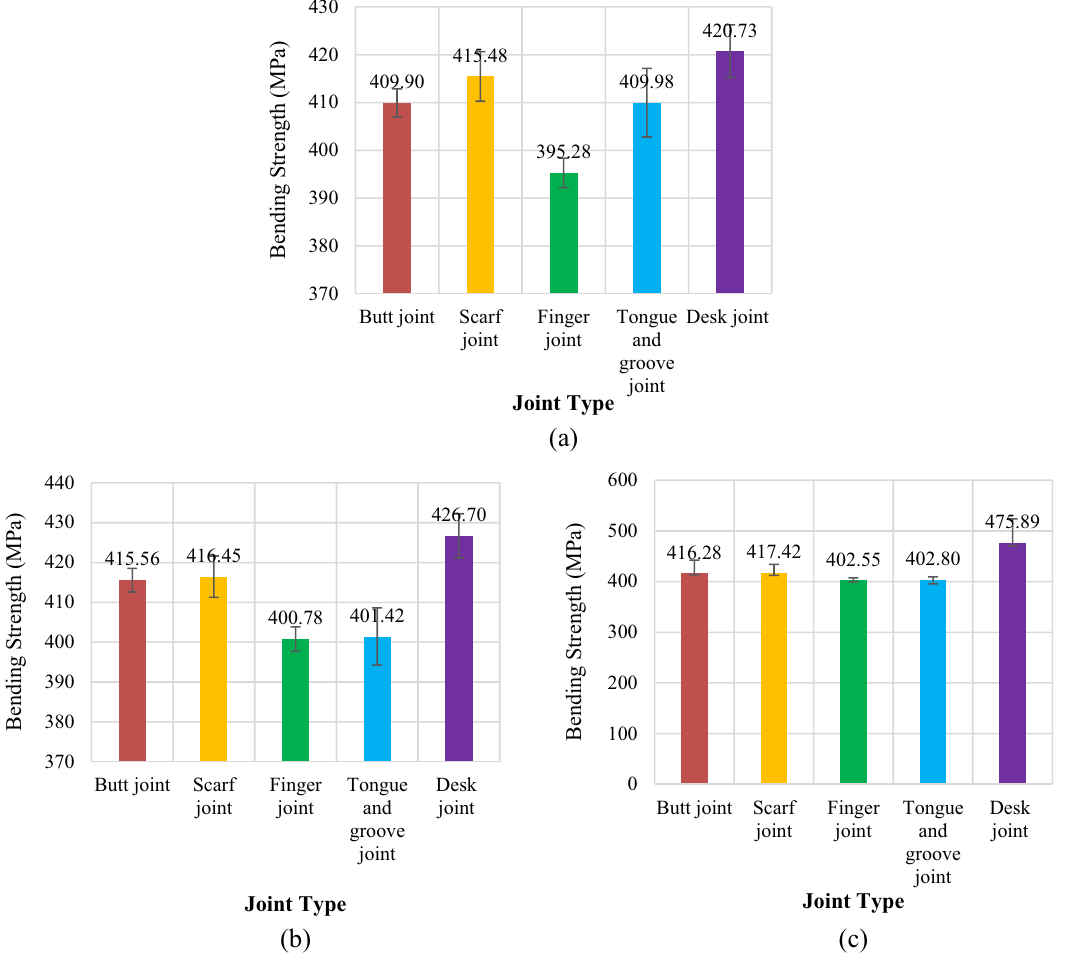
Figure 12: Comparison of bending strength of di ff erent joint types for ( a ) 3 layers, ( b ) 5 layers, and ( c ) 7